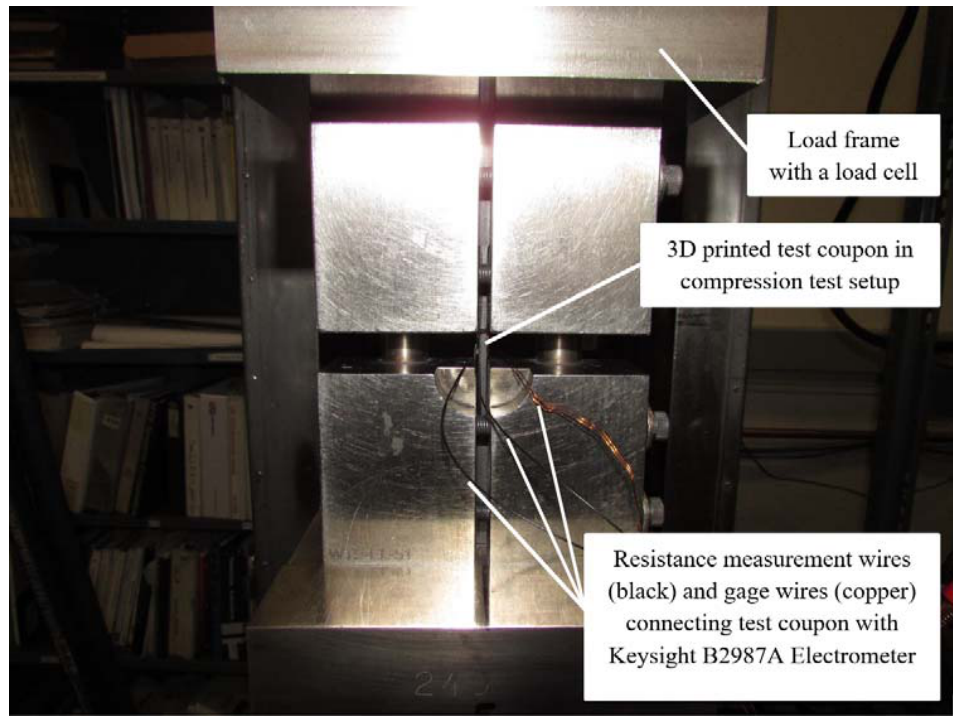
Figure 3. Multifunctional Compressive ‐ Electrical characterization test set up on MTS machine at RTD.